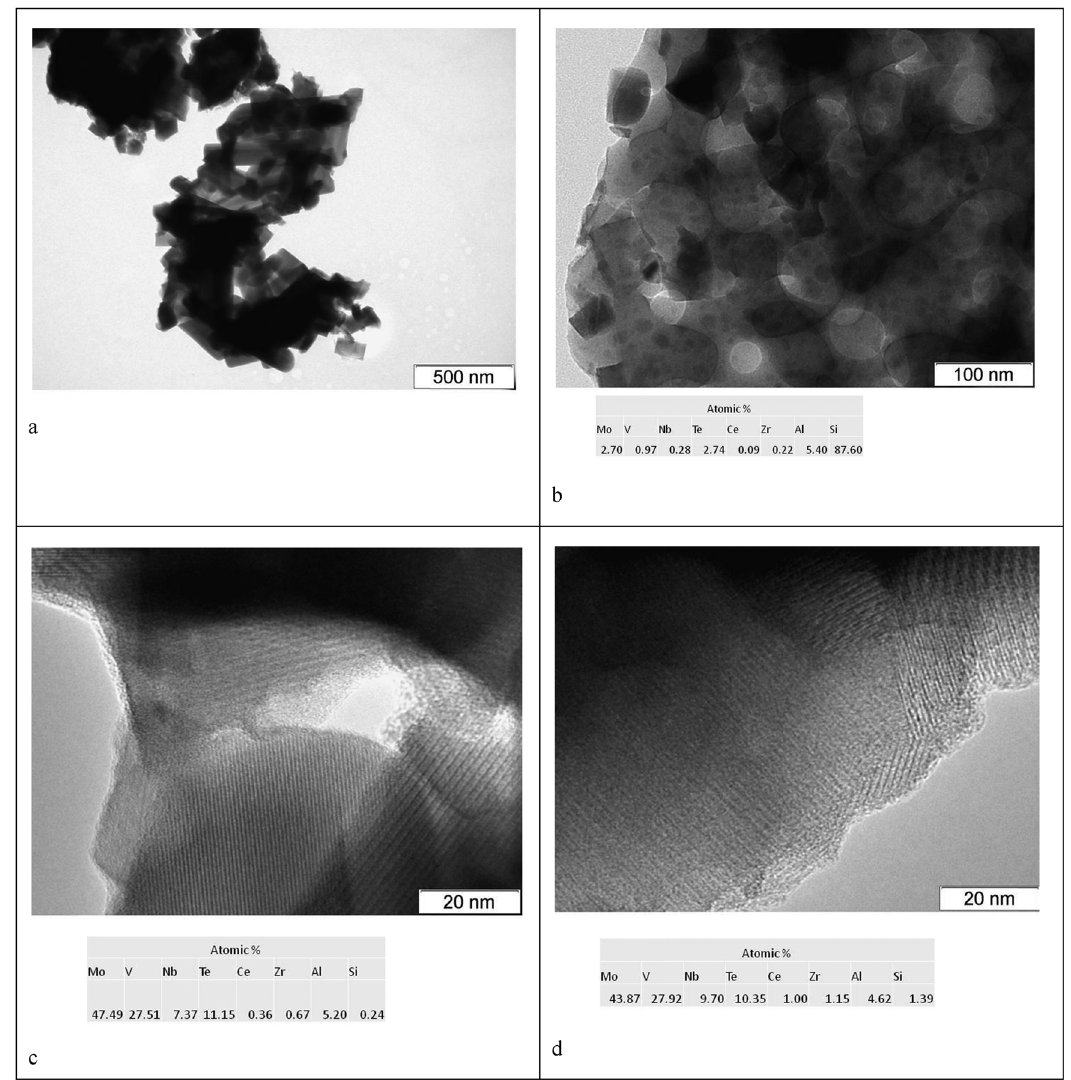
Figure 6: TEM images and EDX data for MoVTeNbO + Zr – Ce - PilC catalyst before reaction. ( a ) general morphology and ( b – d ) selected areas for elemental